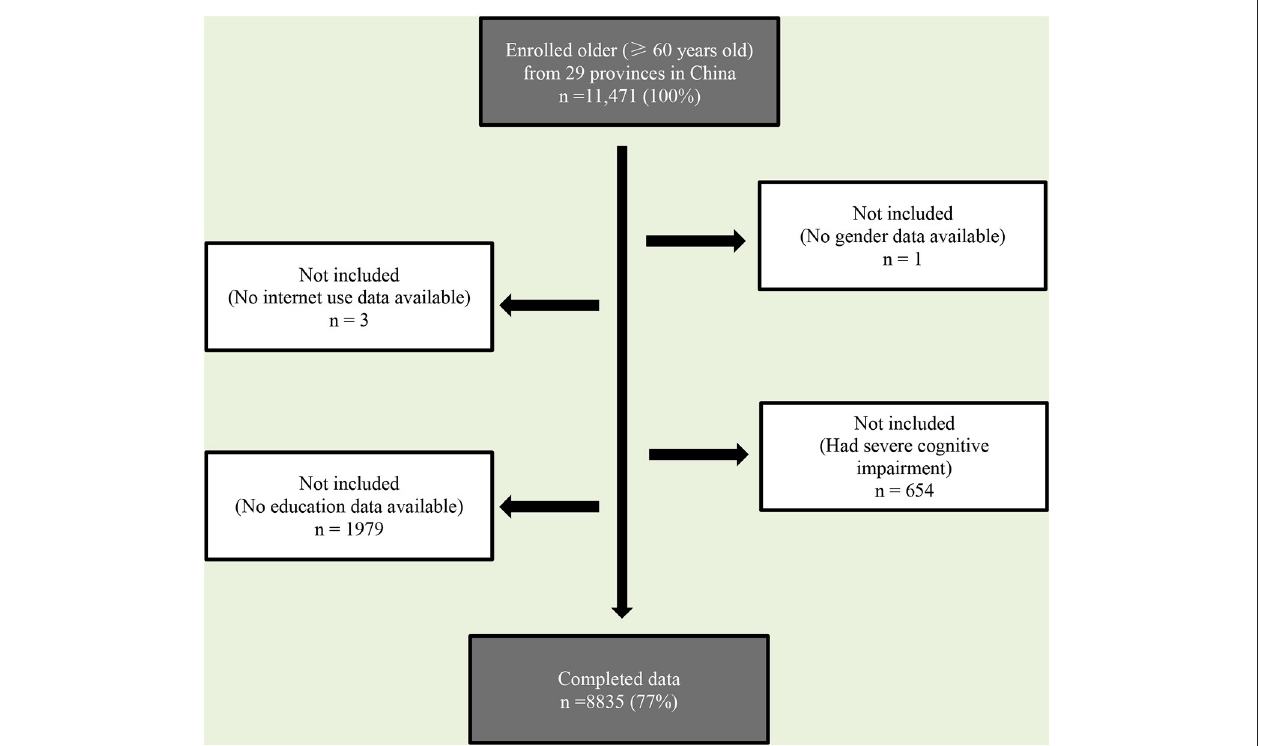
FIGURE 1 | Sample selection